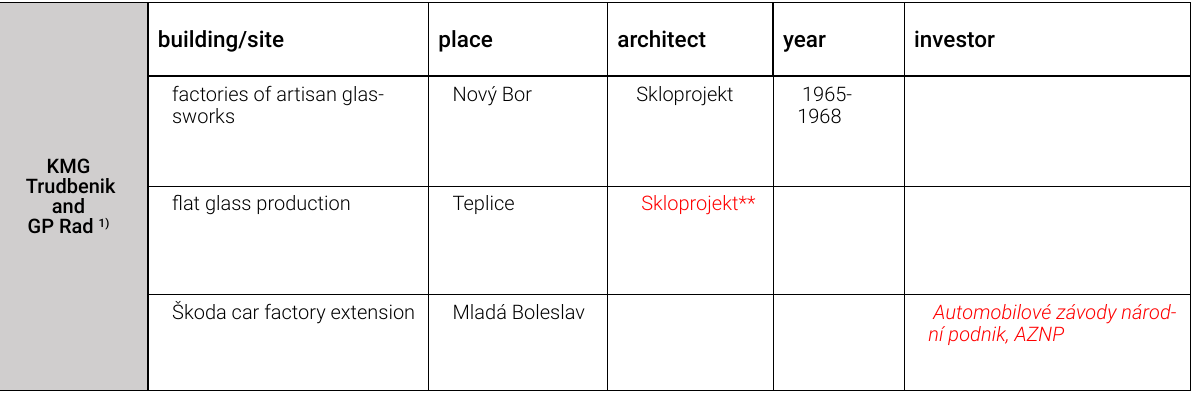
Table 3: Construction Sites of the KMG Trudbenik and GP Rad Consortium